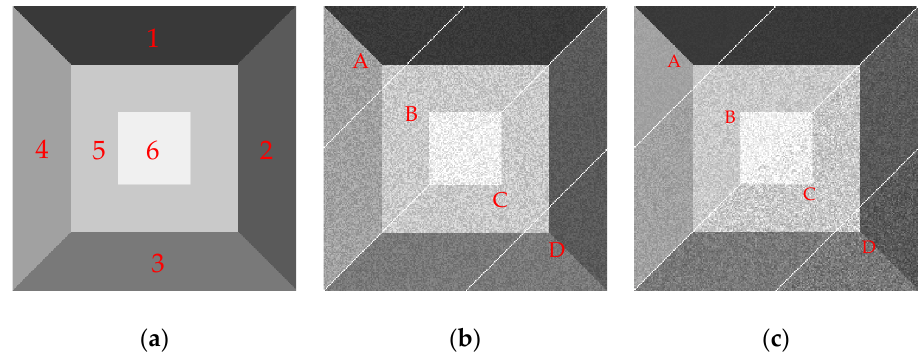
Figure 8. ( a ) The ground truth image; ( b ) Simulated SAR image with speckle noise variance v set to 0.0075, which consists of four regions i.e., A, B, C, and D; ( c ) Simulated SAR image with speckle noise variances set to 0.001, 0.004, 0.007, and 0.01 for regions A, B, C, and D, respectively.